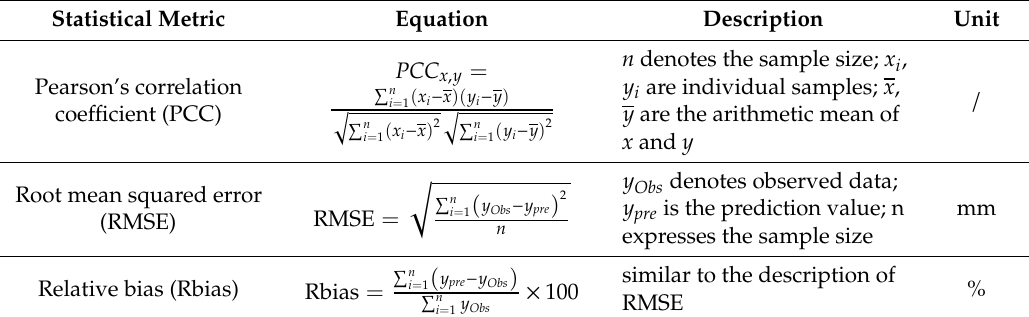
Table 4. Detailed equations and variables involved in the statistical